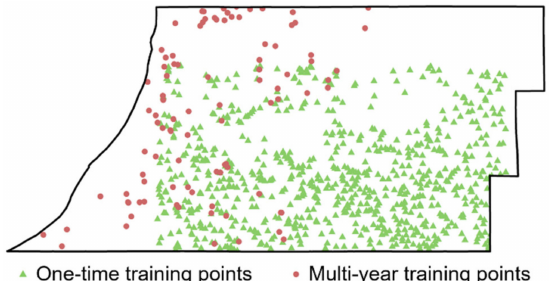
Figure 2. Training points are randomly generated, scattered in crop areas. One-time training points (green triangles) are generated for 2012 (dry) and 2014 (wet) years. Additional points (red dots) are generated for 2005, 2006, 2009, 2010, 2012 and